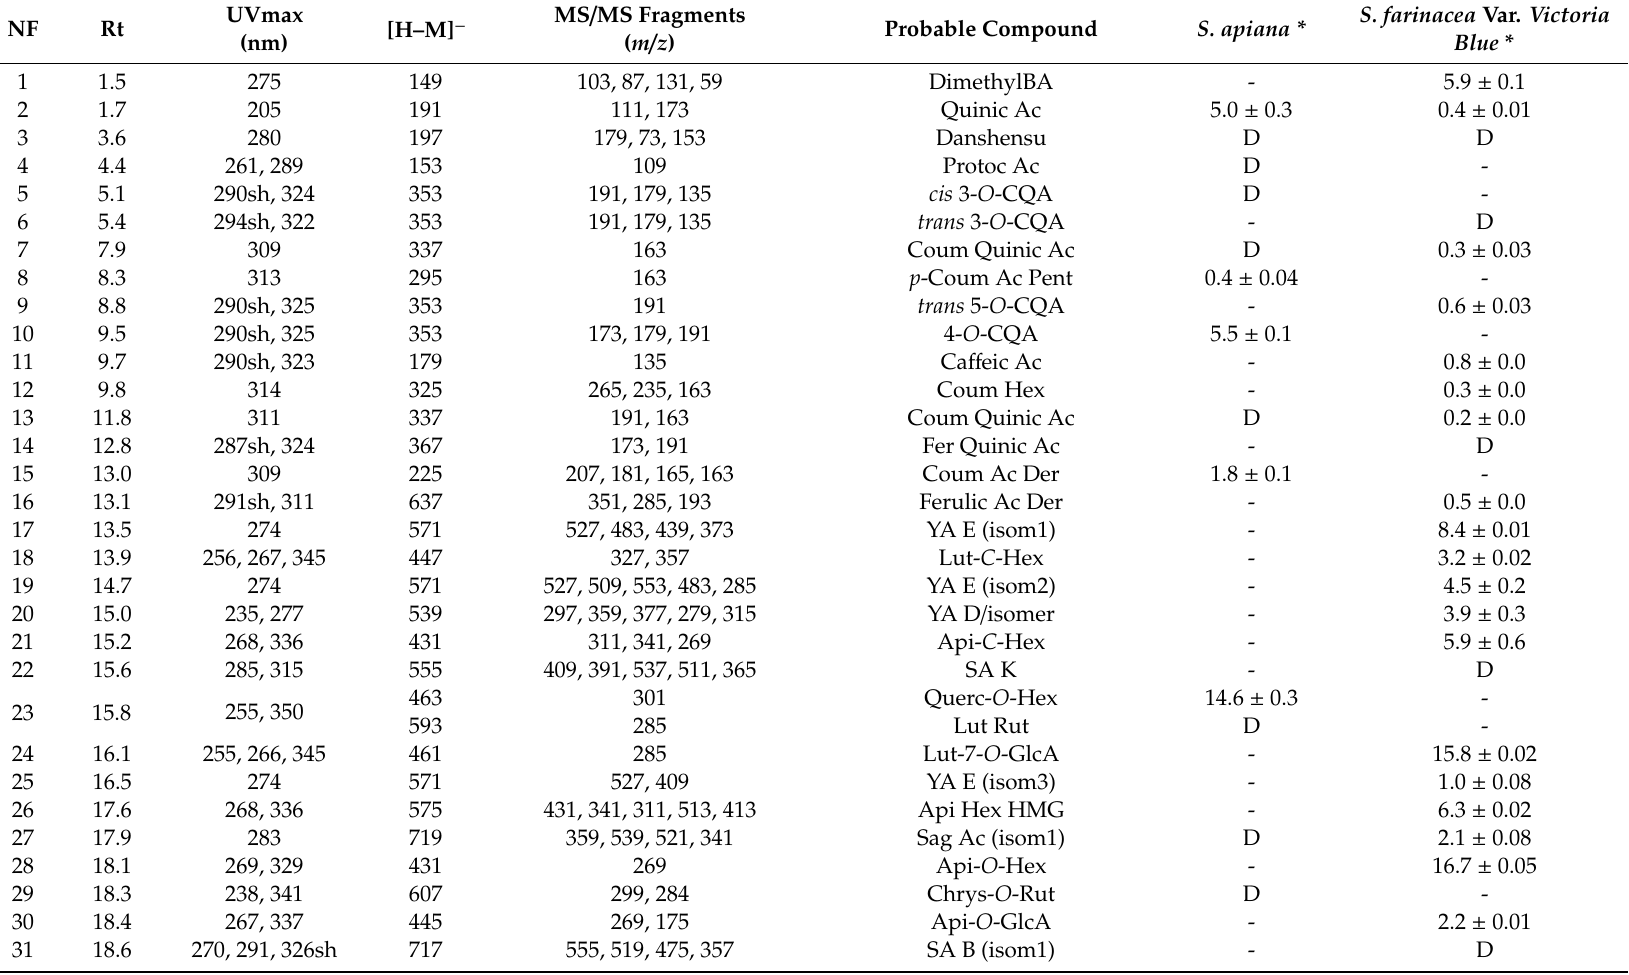
Table 4. Identification and quantification of the compounds identified in S. apiana and S. farinacea var. Victoria Blue decoctions determined by UHPLC-DAD-ESI-MS n